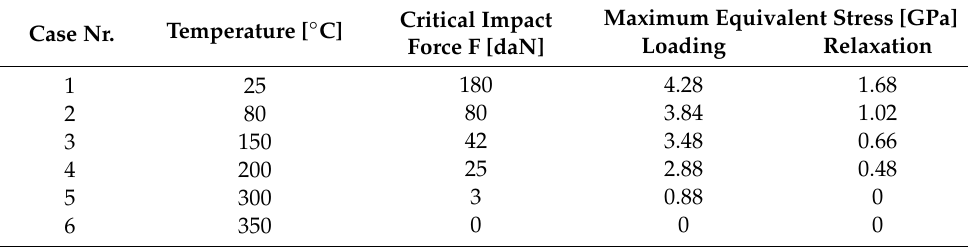
Table 1. Maximum equivalent stresses during loading and relaxation at the fatigue endurance critical forces at various